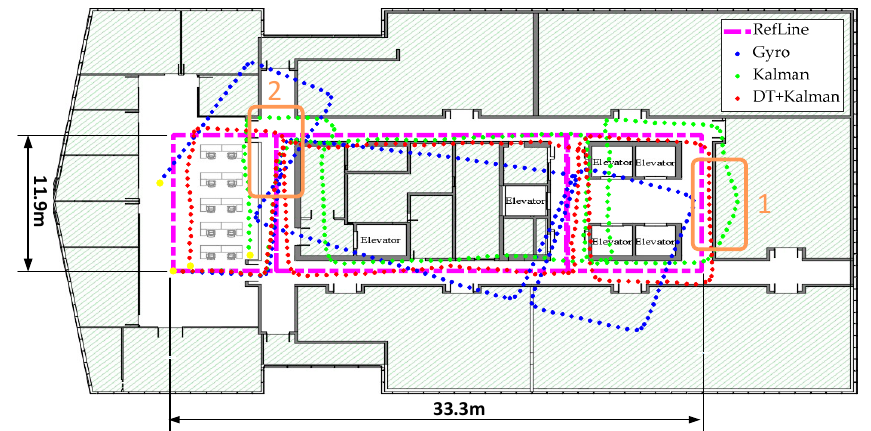
Figure 15. The result of the trajectory test by three different algorithms for indoor pedestrian inertial navigation. The walking time is 131.2 s indoors.